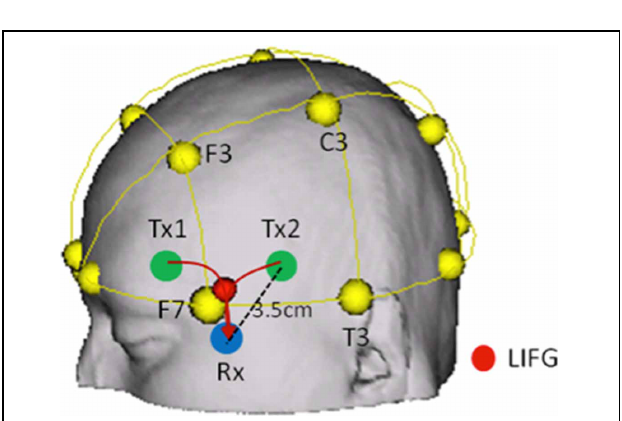
FIGURE 2 | Locus for NIRS monitoring (only left side was shown here). To detect Hb concentration changes at IFG, we positioned one receiver and two transmitter optodes near IFG (BA47) bilaterally. The transmitter and receiver were separated by 3.5cm from each other. The travelling pathways of light are determined by the distance between transmitter and receiver, source wavelengths, characteristics of medium (tissue), and so on. The detecting depth was relevantly corrected to focus on the deep gray matter in inferior frontal